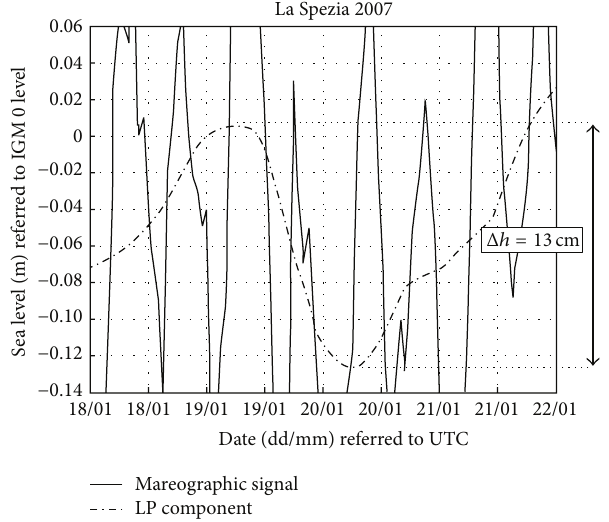
Figure 2: The mareographic signal recorded by La Spezia Newto- nian Meteo-tide Station between 18.01.2007 and 22.01.2007 and its low pass component, 𝐹 𝑐 = 10 −5 Hz (image from [15]).